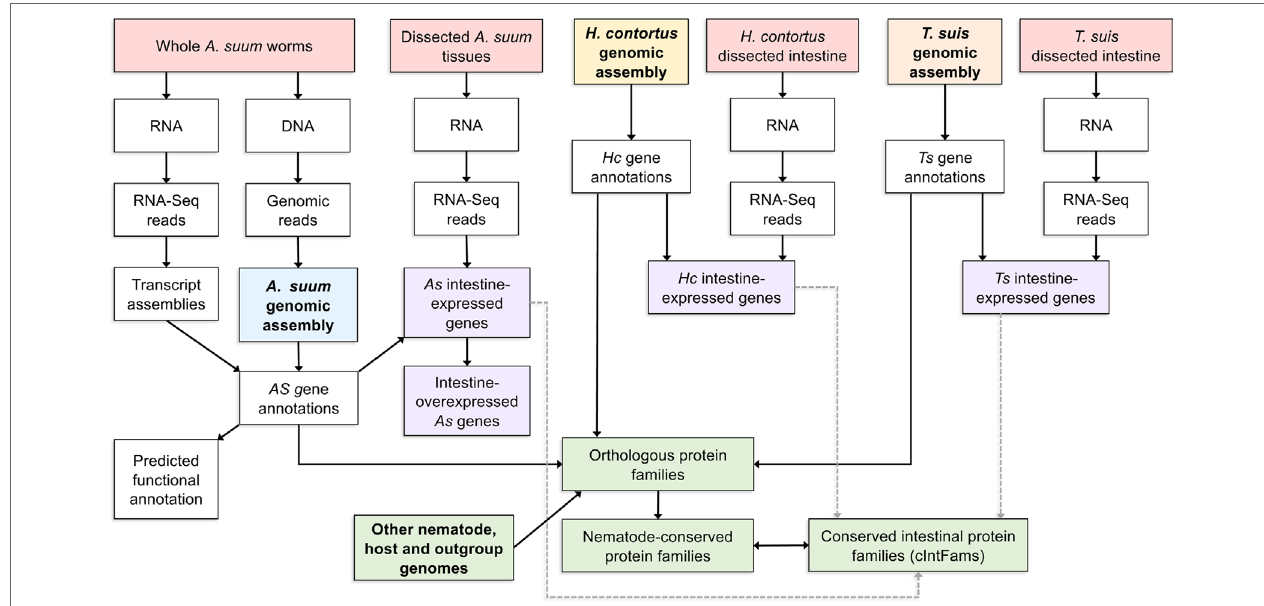
FIGURE 3 | A detailed example of one bioinformatic workflow. Here, a list of conserved intestinal-expressed protein families is produced by intersecting several datasets. The workflow for producing the Ascaris suum genome assembly and annotation is shown but omitted for the other two core